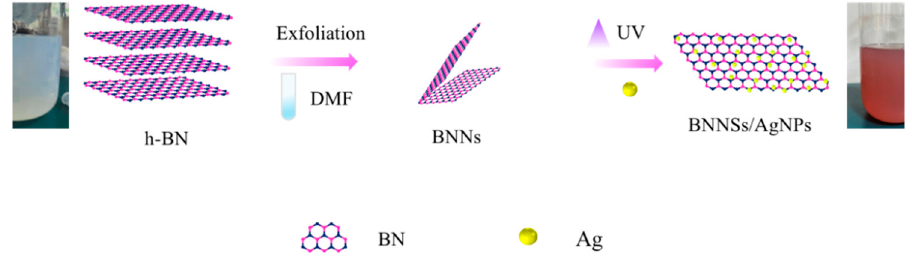
Figure 1. Boron nitride/silver nanocomposite preparation flow chart .